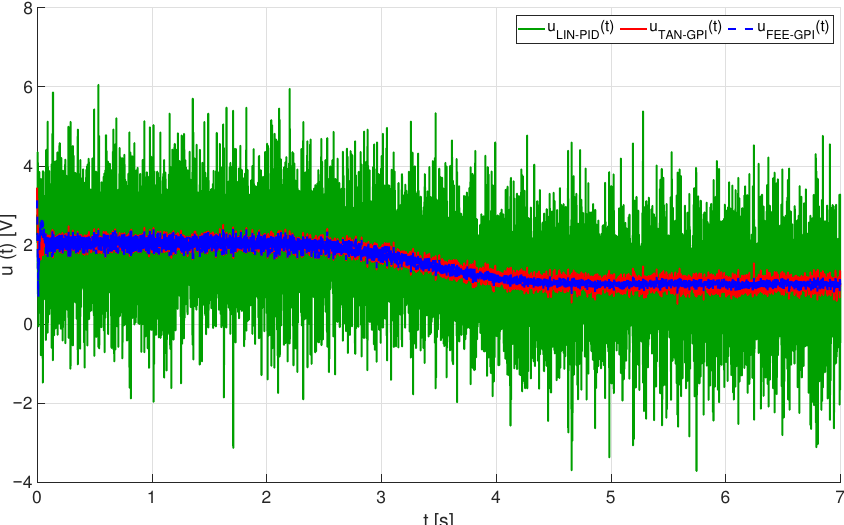
Figure 8. Control input of the magnetic levitation system, u ( t )[ V ] , with measurement noise at the control input and the output of the MLS (Test